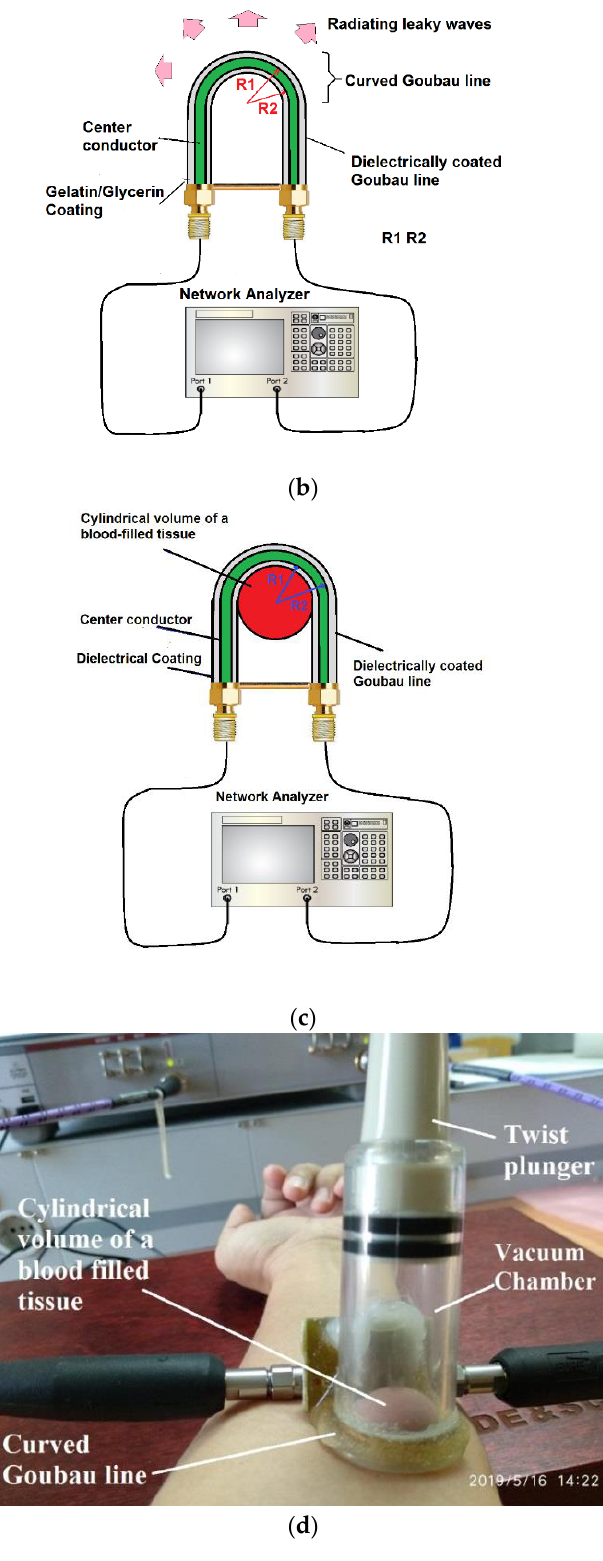
Figure 1. Concept of the proposed blood glucose measurement. ( a ) a straight dielectrically coated Goubau line; ( b ) a measurement setup for a curved Goubau line; ( c ) a measurement setup for the proposed blood glucose measurement; and ( d ) a photo showing how the cylindrical volume of a blood-filled skin tissue is formed using a vacuum suction aspirator.